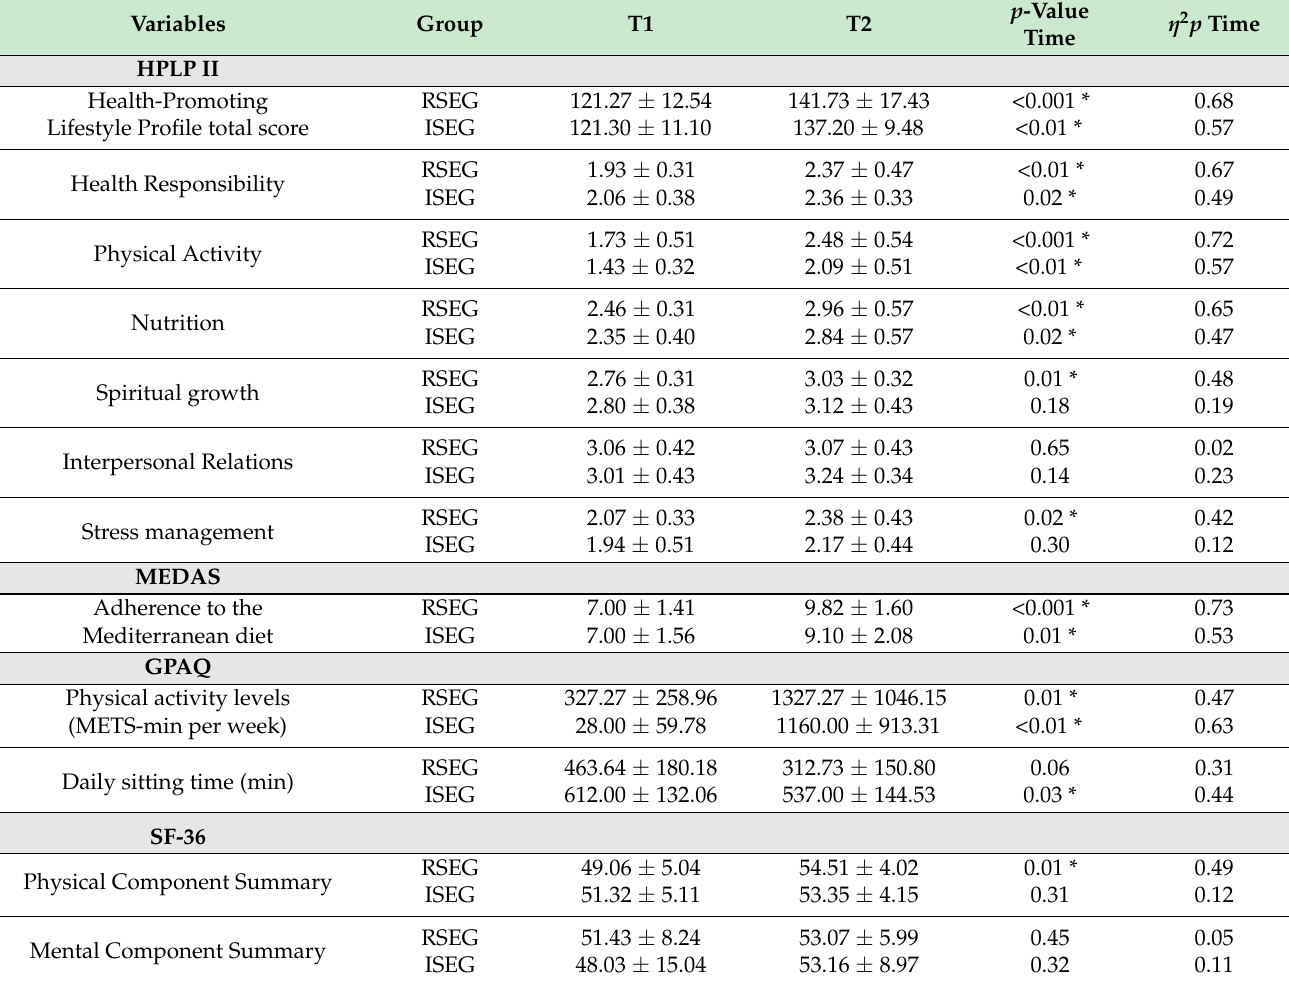
Table 1. Analysis of Lifestyle and Health-Related Quality of Life in The Two